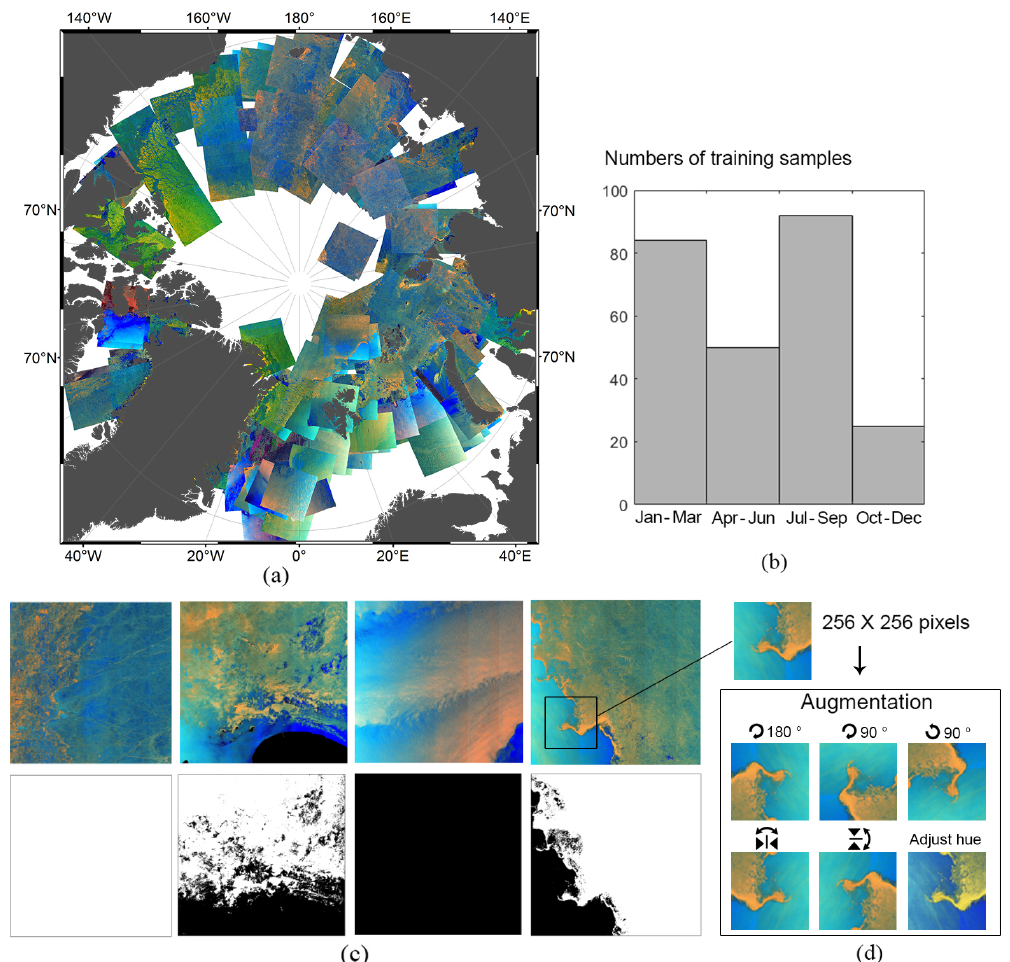
Figure 6. (a) Spatial distribution of the S1 images used for training the sea ice segmentation model. The images are shown as RGB false-color composites, and the land is masked in gray. (b) Histogram of the seasonal distribution of the training data. (c) Examples of data labeling: the top row shows four RGB false-color composite images, and the corresponding labeled images are in the bottom row. (d) Illustration of the augmentation process to increase the quantity and diversity of the samples in the training